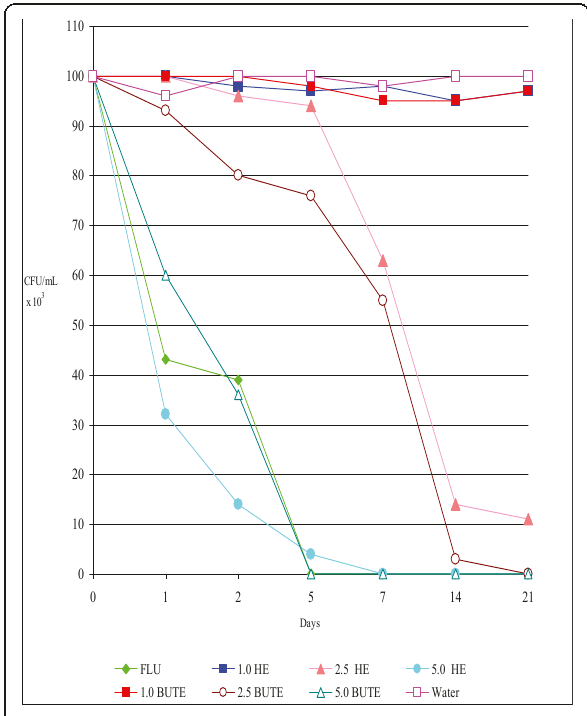
Figure 1 Colony-forming units (CFU/mL) of yeasts in the vaginal exudate of Wistar rats treated intravaginally with hydroalcoholic (HE) and butanolic (BUTE) extracts of Sapindus saponaria at 1.0%, 2.5%, and 5.0%, 100 μ g of fluconazole, or sterile distilled water at 1, 24, and 48 h after induction of the vaginal infection, followed for up to 21 days . Each curve represents the mean (± standard deviation) of the CFU of five rats, in two independent experiments. Experimental vaginal infection by Candida albicans susceptible to itraconazole and fluconazole (SCA).